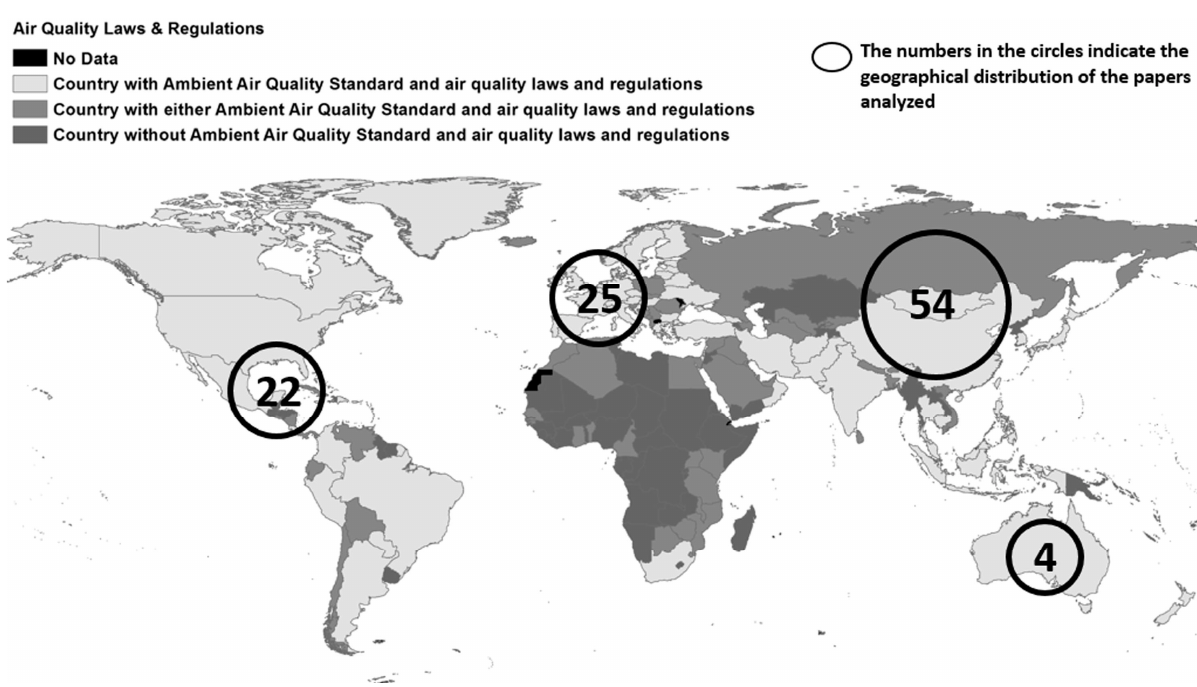
Figure 7. Map indicating global air quality laws and geographical distribution of studies [15].